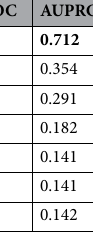
Table 2. AUROC and AUPRC values aggregated for the virtual screening experiment across HLA alleles. The highest values and best performing values in each column are